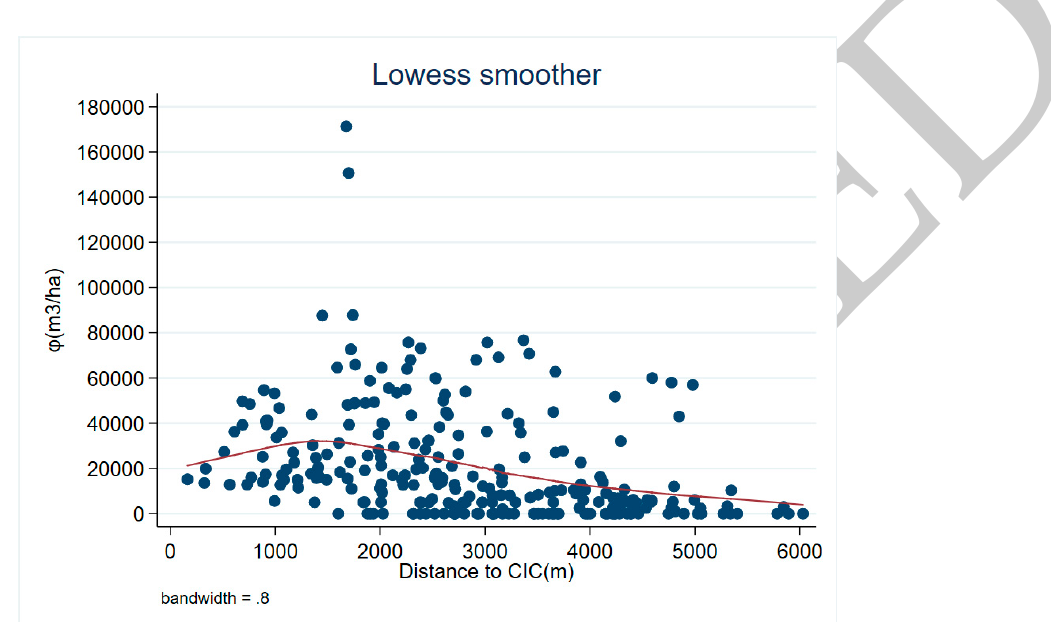
Figure 9. Relationship between the cumulative metabolic rate and distance from the city industrial center (CIC). The dark dot represents the material accumulation of the sample point, and the red line is the fitting line.